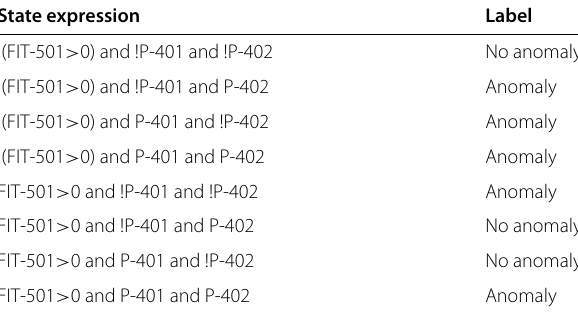
Table 7 State expressions of Invariant #2 for SWaT State expression